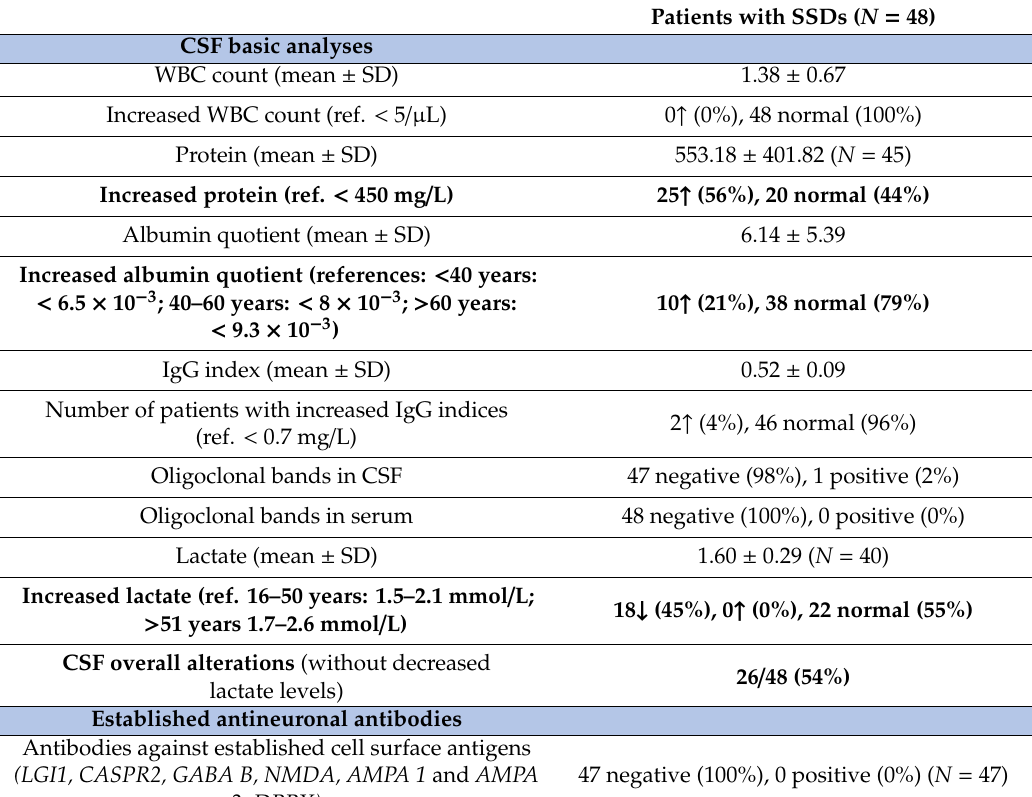
Table 7. Cerebrospinal fluid findings in patients with schizophrenia spectrum disorders (SSDs). Values with alterations in > 10% are marked in bold, parameters with changes in > 5% are written in bold and italics.